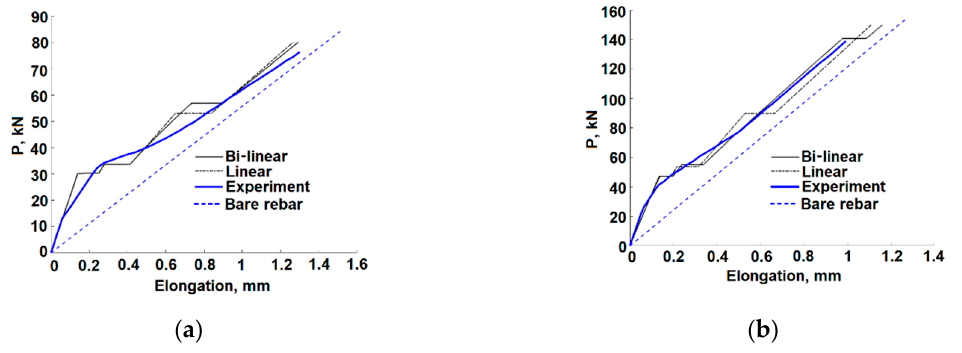
Figure 9. Comparison of bar elongation [11]. ( a ) axisymmetric bar; ( b ) prismatic bar.